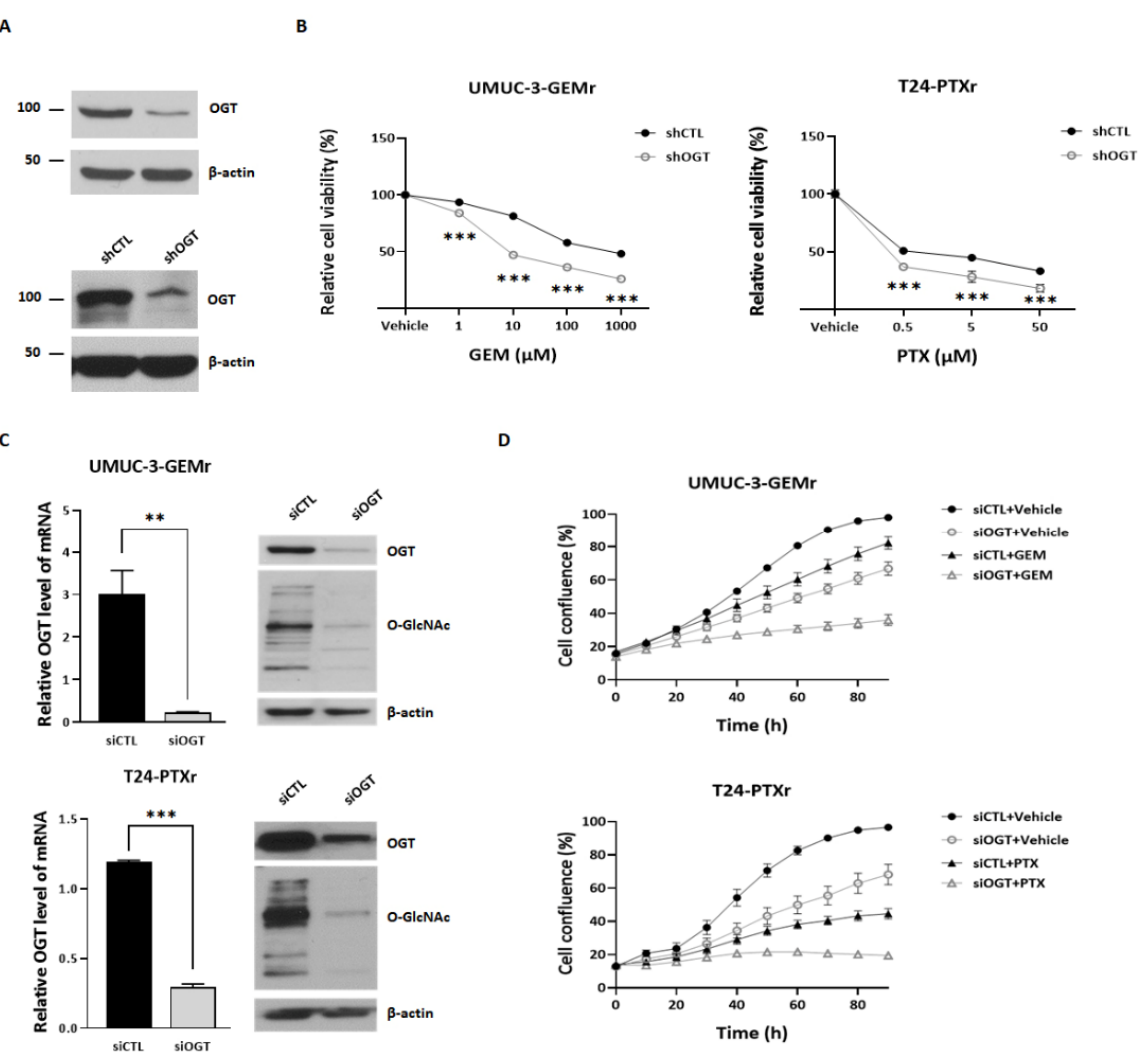
Figure 3. Knockdown of OGT restored sensitivity to chemotherapy drugs in UCB cells with acquired chemoresistance. ( A ) WB examination of OGT expression in UMUC ‐ 3 ‐ GEMr and T24 ‐ PTXr cells stably expressing shCTL or shOGT after incubation for 48 h. The data represent at least three independent experiments. ( B ) Cell viability analysis by MTT assay. UMUC ‐ 3 ‐ GEMr and T24 ‐ PTXr cells stably expressing shCTL or shOGT were treated with a vehicle or the corresponding drugs for 72 h. The data represent at least three independent experiments and error bars indicate the mean ± SEM. *** p < 0.001. ( C ) Immunoblot and qRT ‐ PCR detection of OGT knockdown in UMUC ‐ 3 ‐ GEMr and T24 ‐ PTXr cells reverse transfected with siCTL or siOGT. UMUC ‐ 3 ‐ GEMr and T24 ‐ PTXr cell lysates were immunoblotted against OGT and O ‐ GlcNAc. β‐ actin was used as the loading control. qRT ‐ PCR was used to detect OGT and GAPDH expression in UMUC ‐ 3 ‐ GEMr and T24 ‐ PTXr cells. Error bars indicate the mean ± SEM for three independent regions each. ** p < 0.01; *** p < 0.001. ( D ) UMUC ‐ 3 ‐ GEMr and T24 ‐ PTXr cells were reverse transfected with siCTL or siOGT. After 24 h, UMUC ‐ 3 ‐ GEMr cells were treated with a vehicle or 7 μ M GEM and T24 ‐ PTXr cells were treated with a vehicle or 200 nM PTX. Cells were incubated in the IncuCyte TM analyzer to monitor cell proliferation. Cell confluence levels were measured by the IncuCyte TM analyzer in real time and are presented as a percentage. The data represent at least three independent experiments and error bars indicate the mean ± SEM.